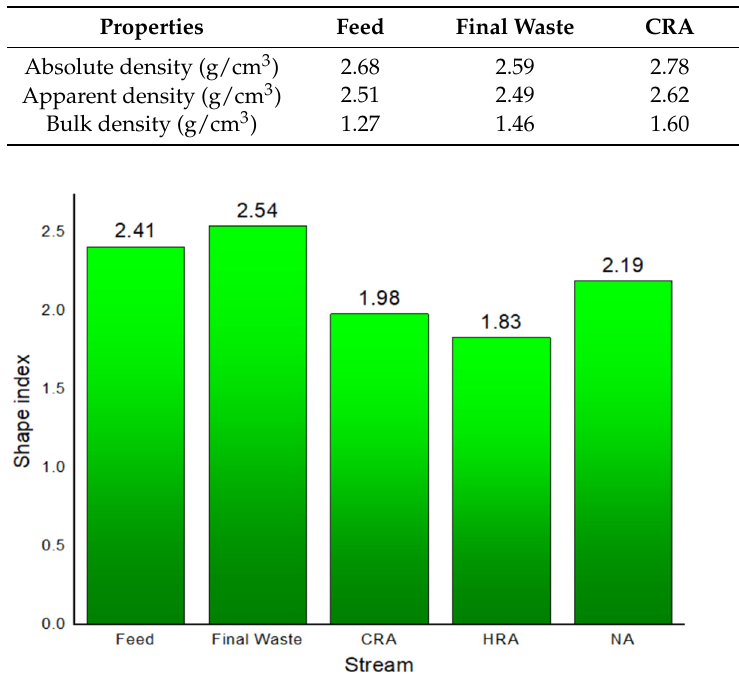
Figure 7. Shape index of different aggregate types, measured through the caliper method (see Sec- tion 2.4 for more